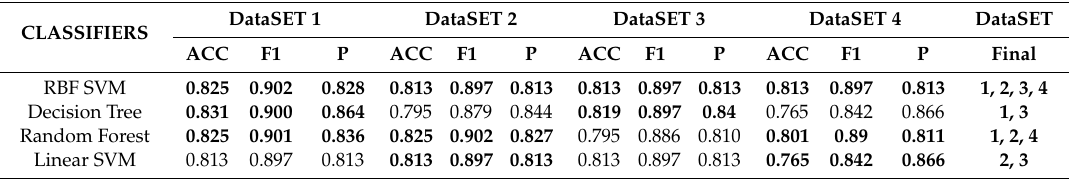
Table 4. Comparison of